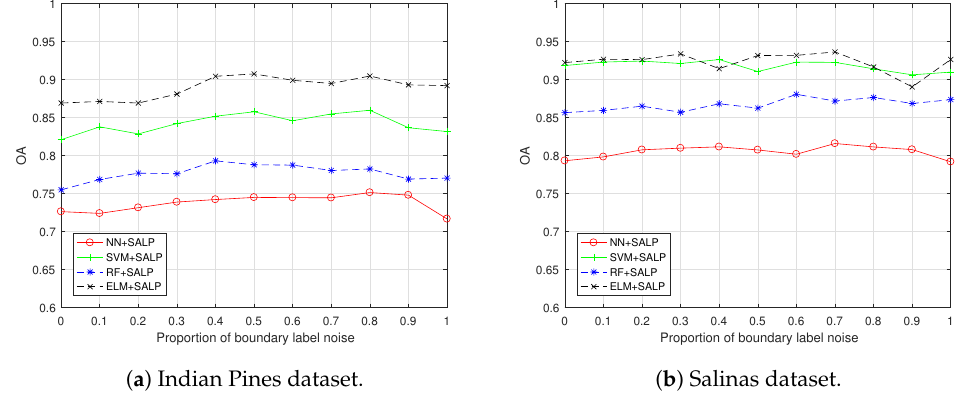
Figure 12. OA trend of SALP with different proportion of boundary label noise in the “both” setting. The results of NN, SVM, RF and ELM are labeled in red “o”, green “+”, blue “*”, and black